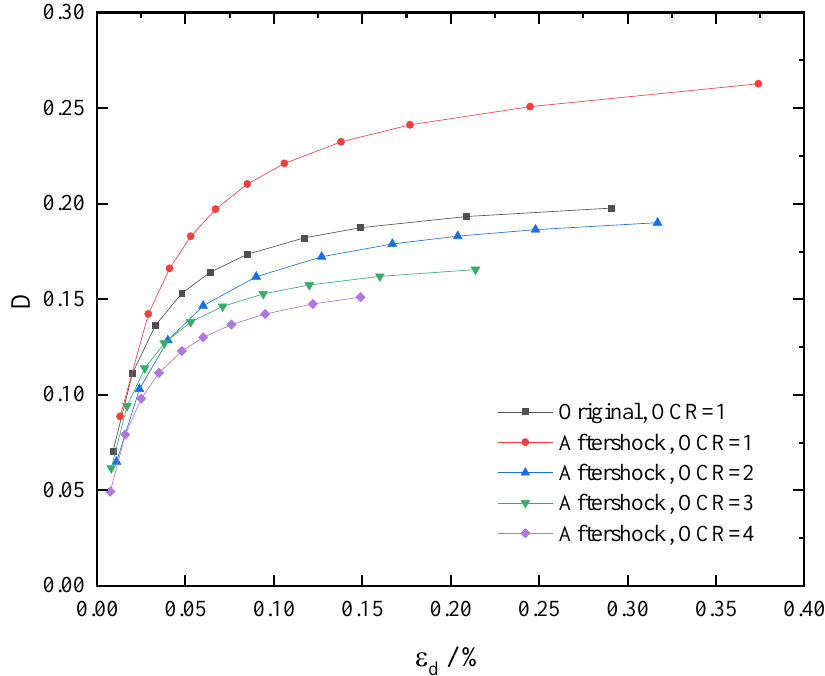
Figure 11. Curves of the damping ratio versus the dynamic strain of the saturated loess under different test conditions.